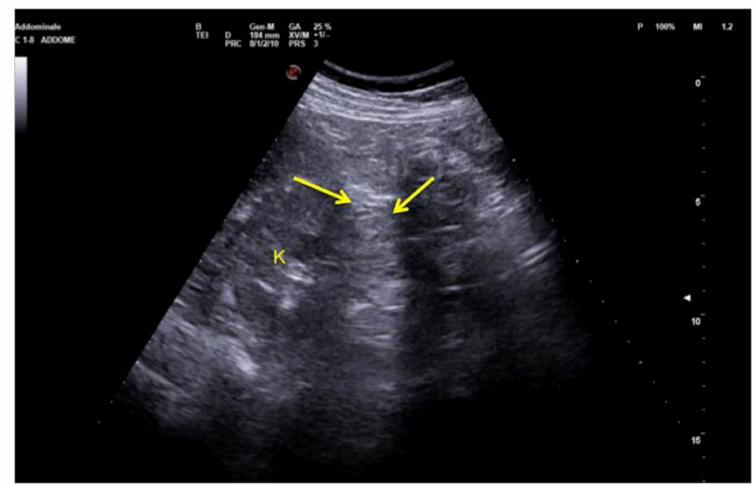
Figure 9. Coronal images of the left flank. Refraction of the US beam at the lower pole of the spleen causes apparent disruption of the of the middle third of the left kidney (arrows). K: kidney.